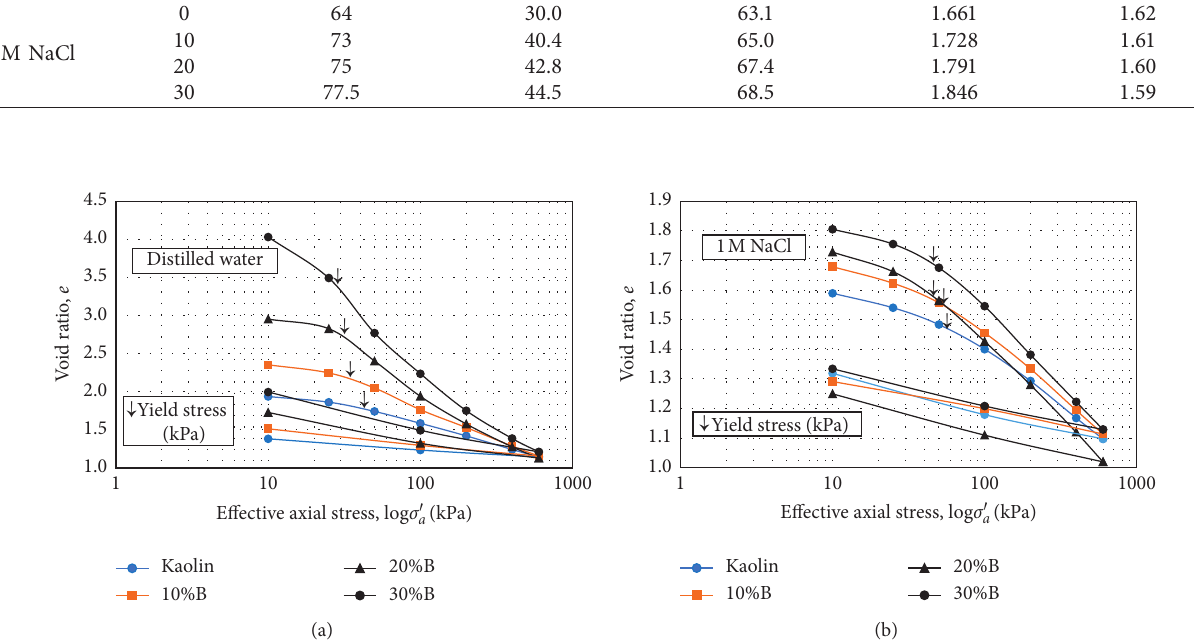
Figure 2: Void ratio—effective axial stress relationship. (a) Distilled water; (b) 1 M NaCl.